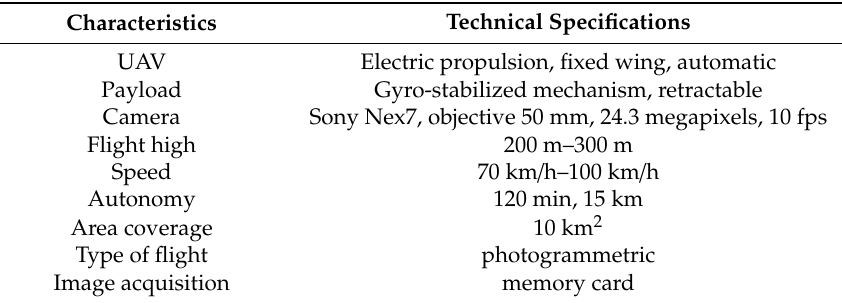
Table 1. UAV—characteristics and technical specifications.